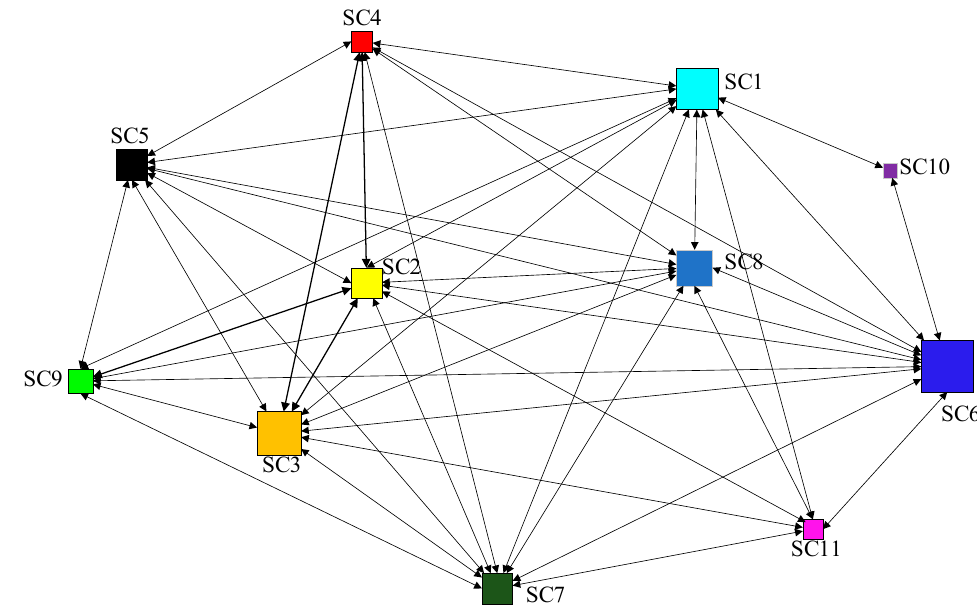
Figure 3. The network of tower crane safety collaborative governance for multiple stakeholders. The network indicators used in SNA usually include density, centrality, and struc- tural hole index [51]. Network density and centralization can measure the status of the entire safety collaborative governance network, while indicators such as centrality and structural hole evaluate the status of each stakeholder in the network [52]. The positions of stakeholders in the network can influence their behavioral decisions and the effect of safety governance. The individual behavioral decision of each stakeholder could influence the entire network, thereby achieving enhanced safety in tower crane operations [53].